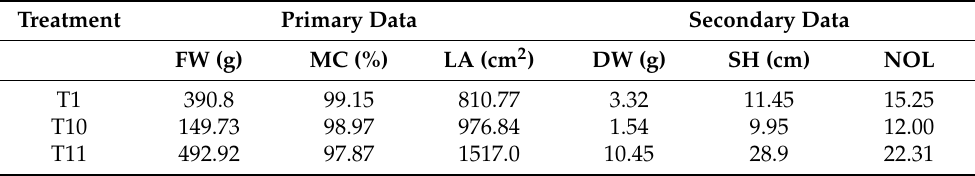
Table 9. Primary and secondary data comparison of growth responses for plant elongation process.